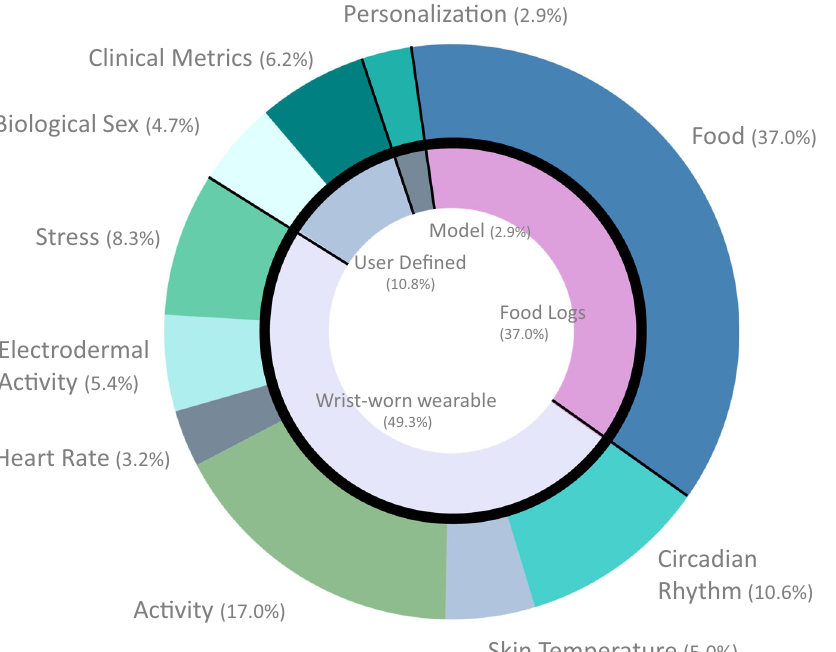
Fig. 5 Importance of 69 domain-driven and data-driven features in glucose predictions. Importance was determined from a random forest feature selection model using impurity-based features. The outer circle shows relative percent of importance for the categories food, circadian rhythm, activity, stress, gender, clinical metrics, personalization, electrodermal activity, heart rate, and skin temperature. The inner circle shows relative importance by source of features, including food logs, the wrist-worn wearable, user-de fi ned features, and features de fi ned for/by the